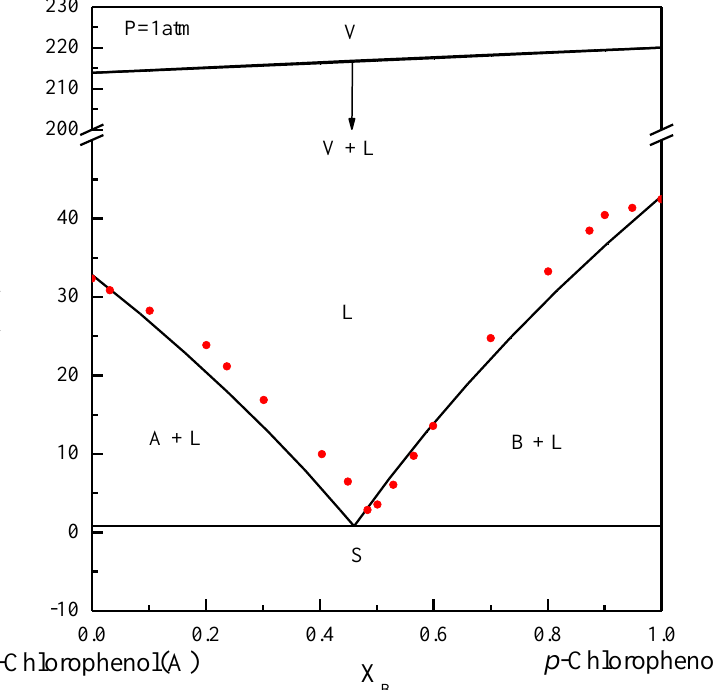
Figure 1. The phase diagram of m -chlorophenol (A-component) and p -chlorophenol (B-component) at P = 1 atm. The solid circle data point represents the experimental SLE reported by Her et al. [2]. Table 1. Some physical properties for m -chlorophenol and p -chlorophenol [27]. Property m -Chlorophenol p -Chlorophenol Molecular weight